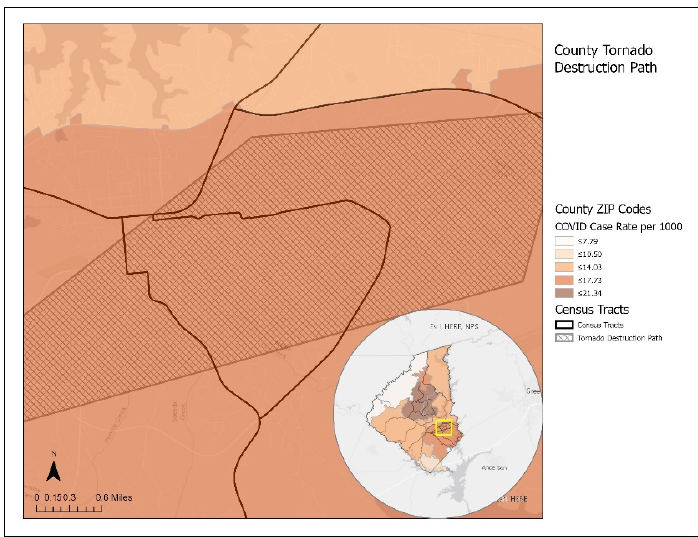
Figure 2. Inset of the Targeted Study Area that Included the Path of the EF-3